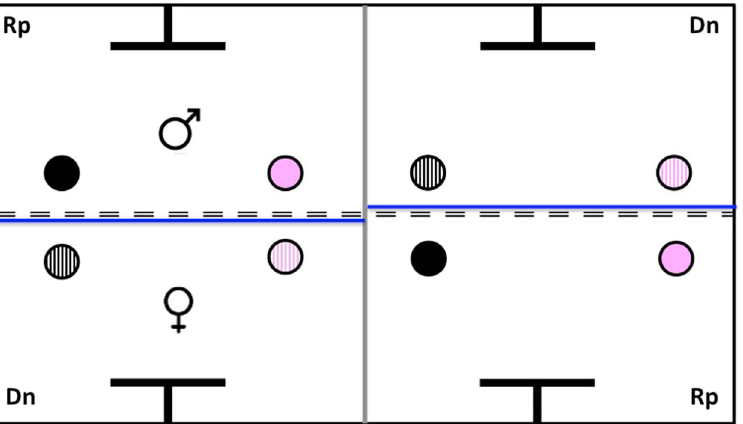
Figure 3. Top view of the experimental apparatus replicating an Alternating Prisoner’s Dilemma game. The two pair members - one in the donor chamber (Dn) and the other in the recipient chamber (Rp) - were separated only by a grid represented by a dotted line. In both chambers, the pink feeder represents the decision to cooperate while the black feeder represents the decision to defect. The crosshatched feeders placed in the Dn chamber were covered by a transparent lid, contrary to those placed in the Rp chamber. After the donor (the female in that case) has made a decision, the removable partition, which is represented by a grey line, was lifted, thereby allowing the birds to move to the adjacent chamber and switch